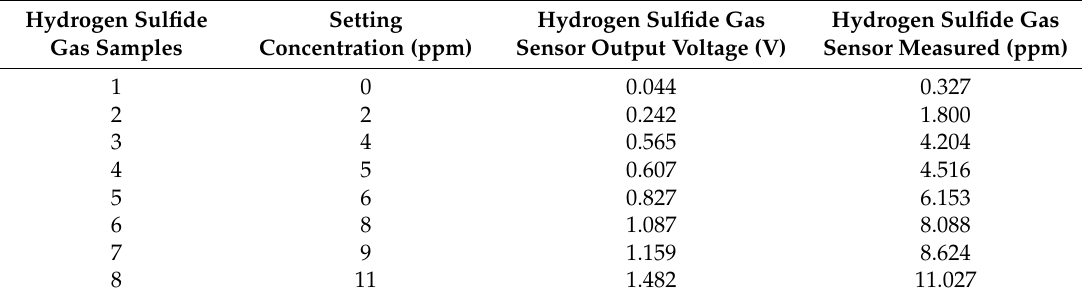
Table 1. Experimental Data.